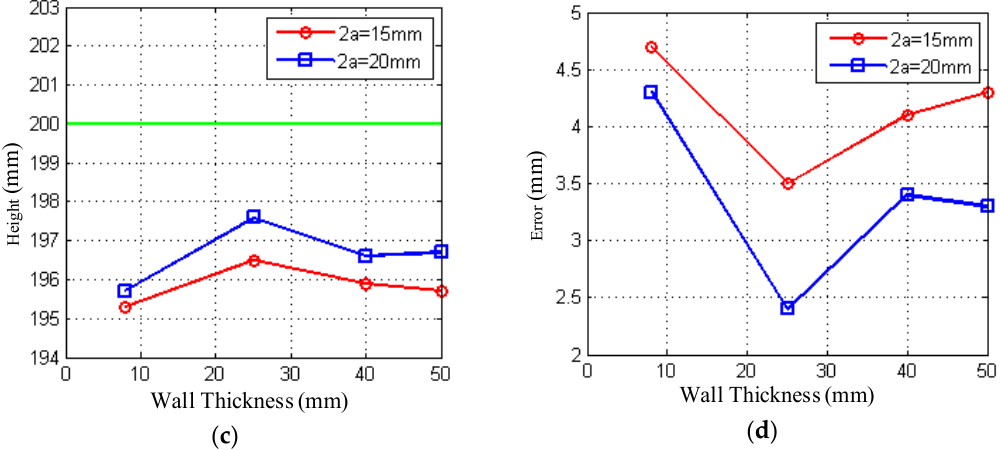
Figure 7. Experimental result. ( a ) Relationship of energy circle diameter and container wall thickness; ( b ) Sound pressure difference between two critical positions at different wall thicknesses; ( c ) Liquid level value at different wall thickness; ( d ) Error at different wall thickness.